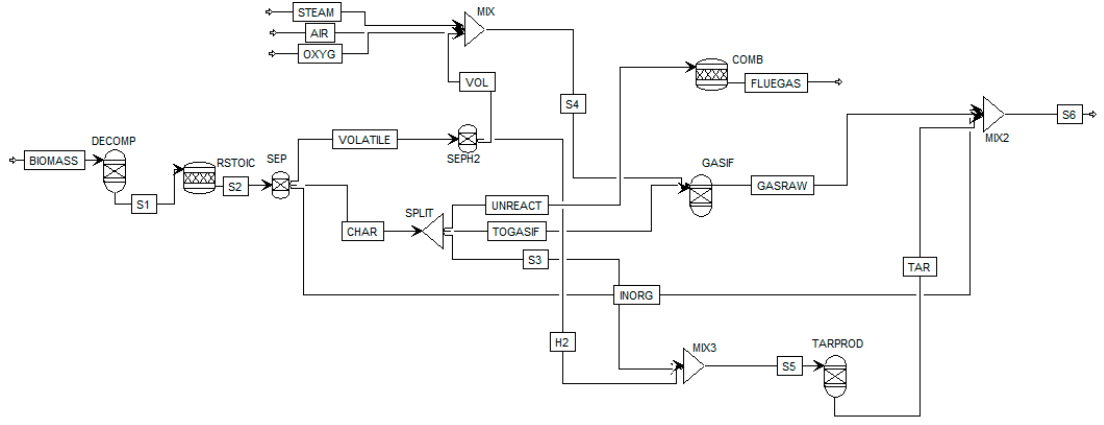
Figure 1. Flowsheet of the Aspen Plus simulation. Table 1. Gasification reactions [36].